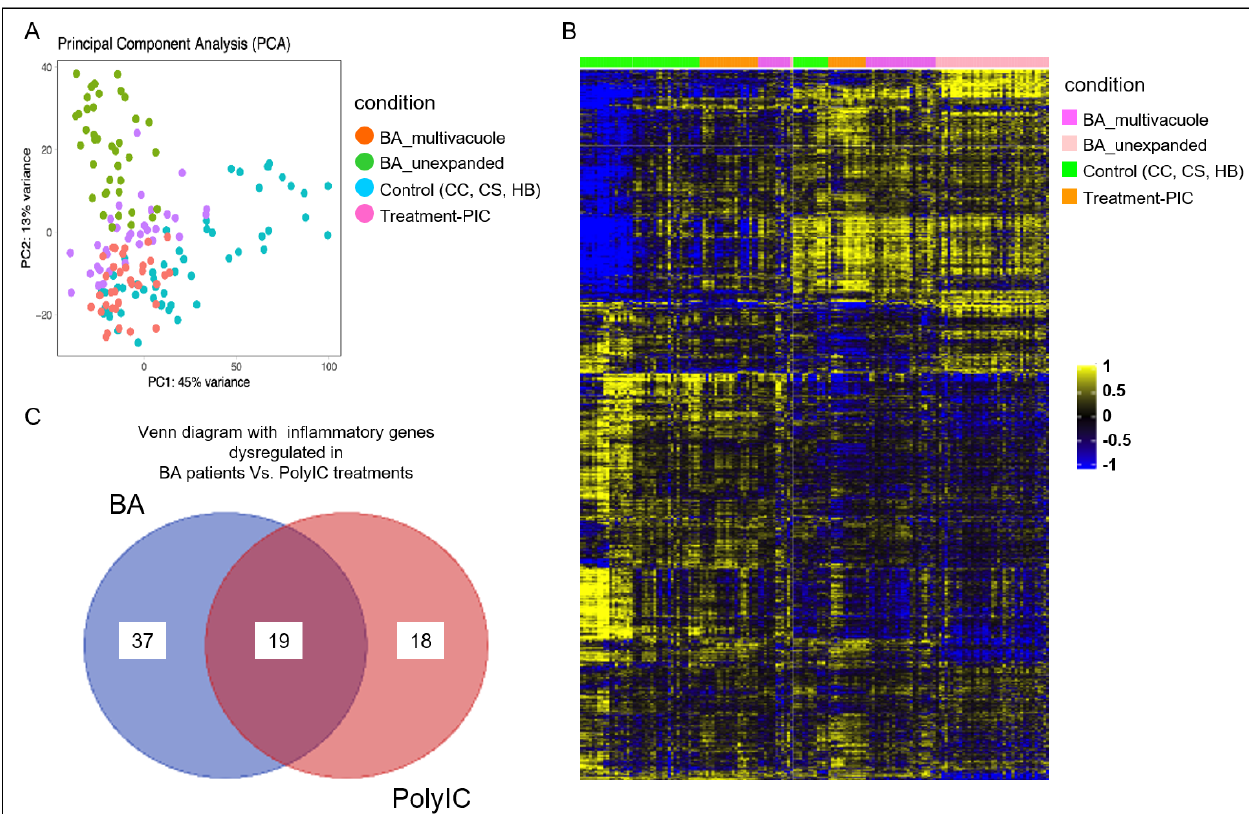
Figure 2. Poly I:C treated organoids and BA organoids displayed similar transcriptomic signatures. ( A ) Principal Component Analysis (PCA) showing clustering of n = 156 bulk transcriptomes from organoid samples from poly I:C treatment, controls (CC, SC, HB) and BA, each dot represents an organoid. ( B ) Heatmap showing the mRNA expression levels of total genes (1356 nos.) that are differentially expressed poly I:C treatment when compared to controls (yellow-high expression; blue— low/no expression), and BA. Each column represents a gene and each row represents an organoid from the conditions indicated by color bars to the right. ( C ) Venn diagram showing inflammatory genes dysregulated in BA patients versus poly I:C treated control